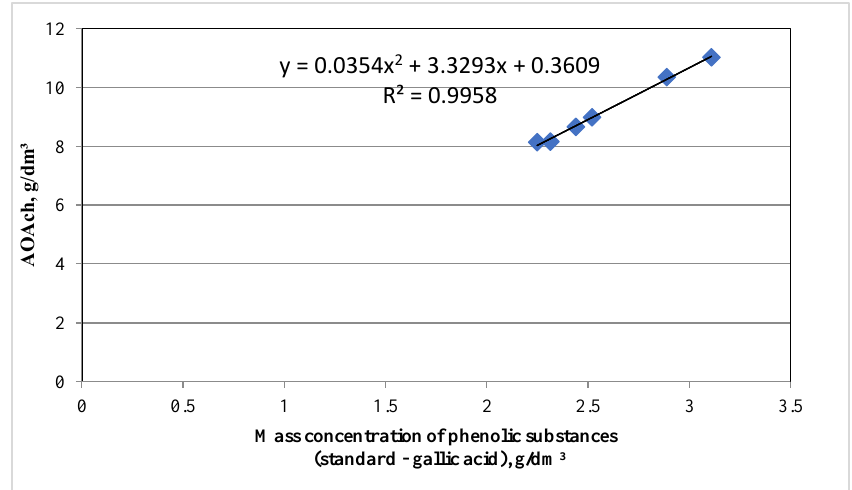
Figure 5. Correlation of the AOA ch index of red table wine materials and the mass concentration of phenolic substances (standard — gallic acid).